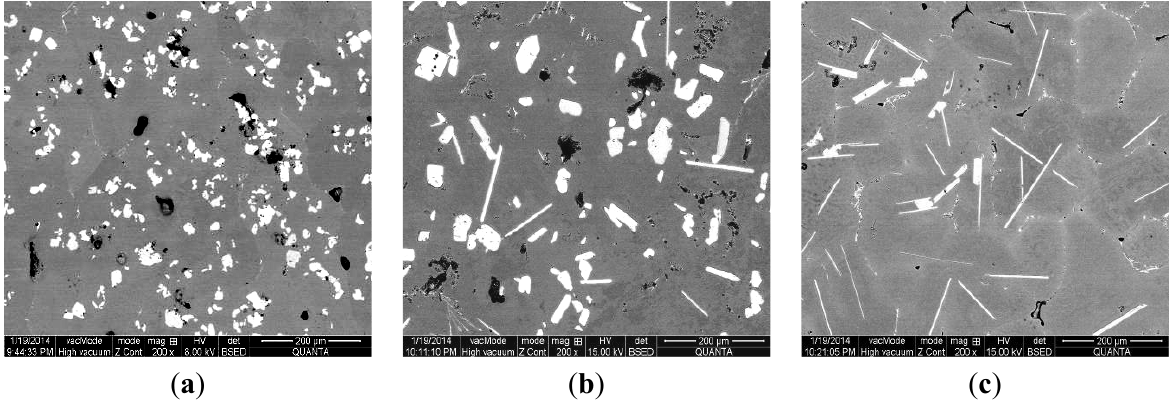
Figure 1. Microstructures of three types of Al–5Ti master alloy: ( a ) master alloy 1 # with blocky TiAl particles; ( b ) master alloy 2 # with mixed TiAl 3 particles. with needle–like TiAl 3